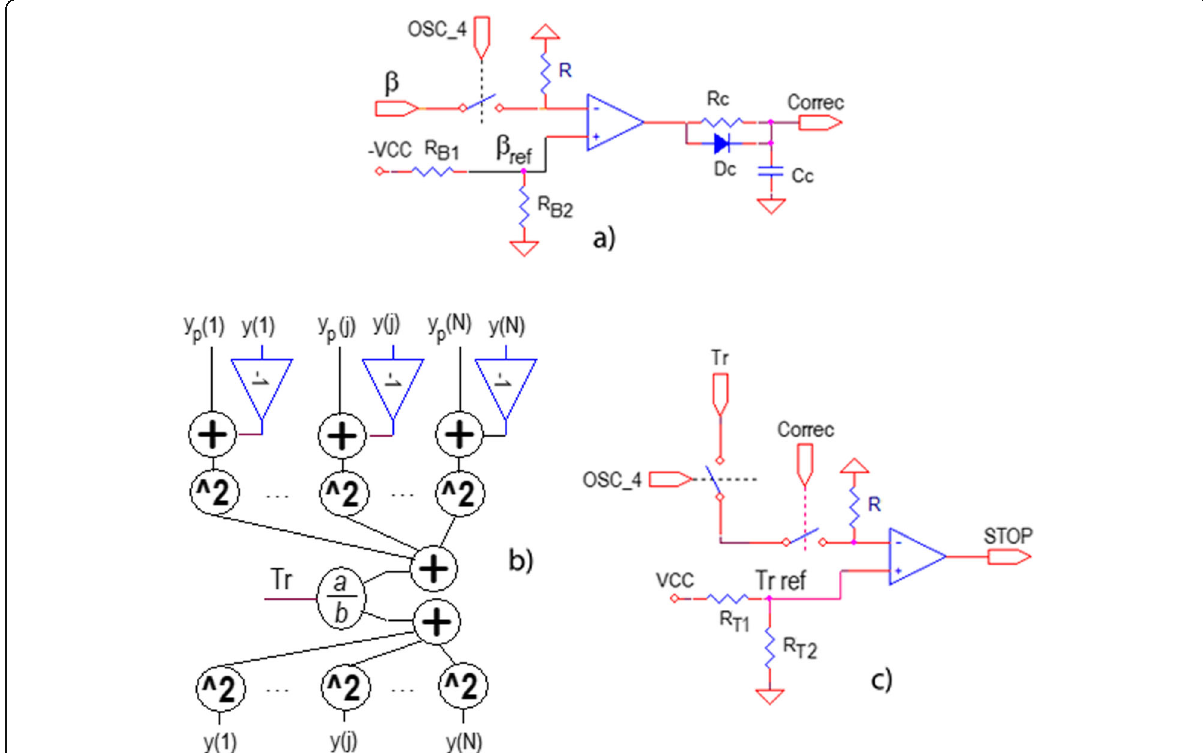
Fig. 9 Circuits in block 4: a checking the condition β < β REF (if the condition is satisfied, Correc signal is activated), b updating the threshold value Tr , c checking the stopping criterion T r < T